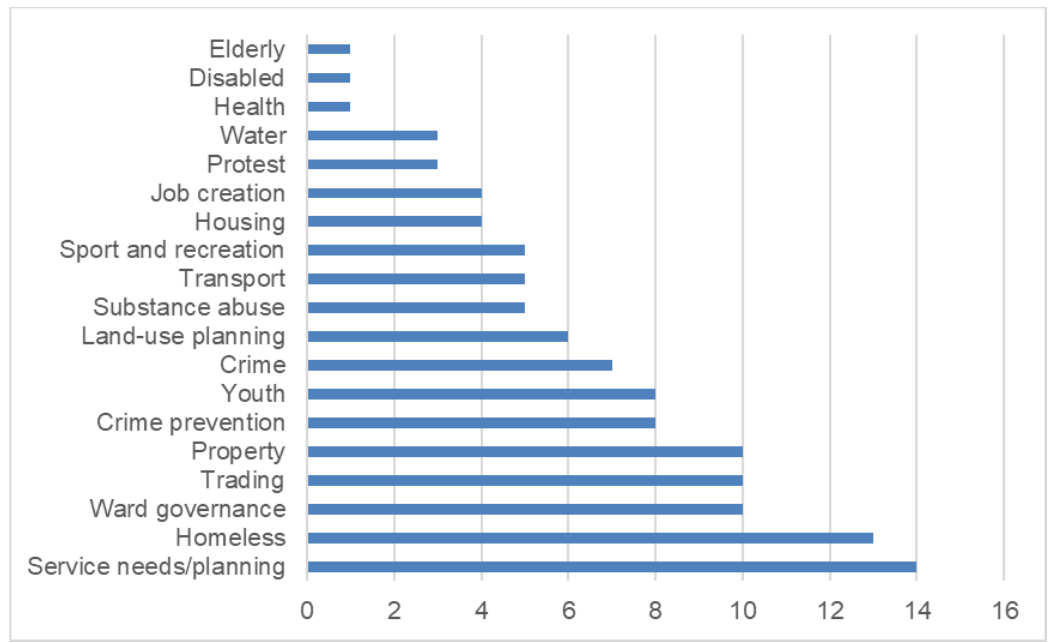
Figure 2: Frequency of issue areas in wards in community media